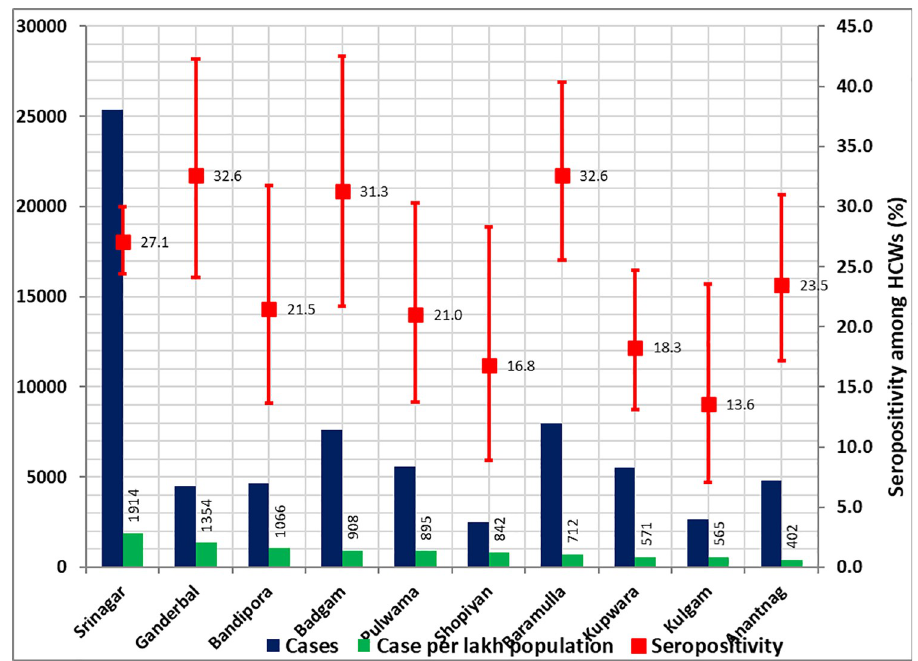
Fig 1. District–wise SARS-CoV-2 seroprevalence (95% CI) in healthcare workers of Kashmir and reported cases of infection in the population.